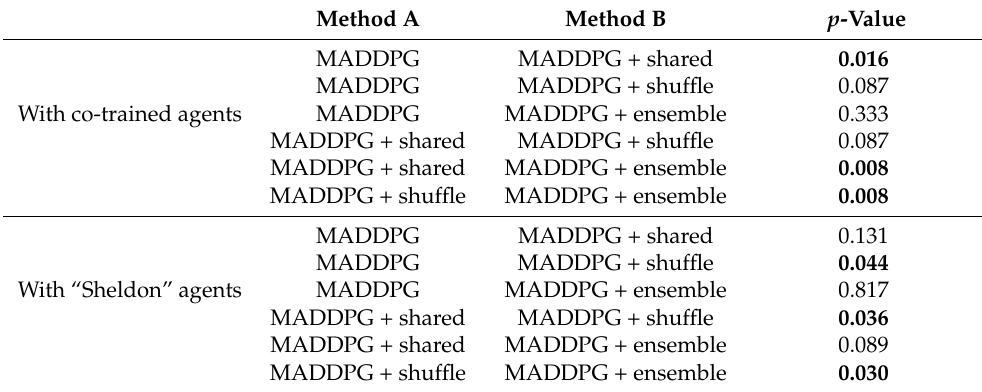
Table A3. Metrics reported in [5] for experiments. Average distance refers to the distance from each landmark to the closest agent, averaged over episodes, timesteps, and landmarks. Averaging over timesteps is used to take into account how fast the agents achieve the final target. # collisions refers to the average number of collisions over episodes and timesteps. We also show results from [5] for context, but it was impossible to exactly match them, as the codebase had changed since